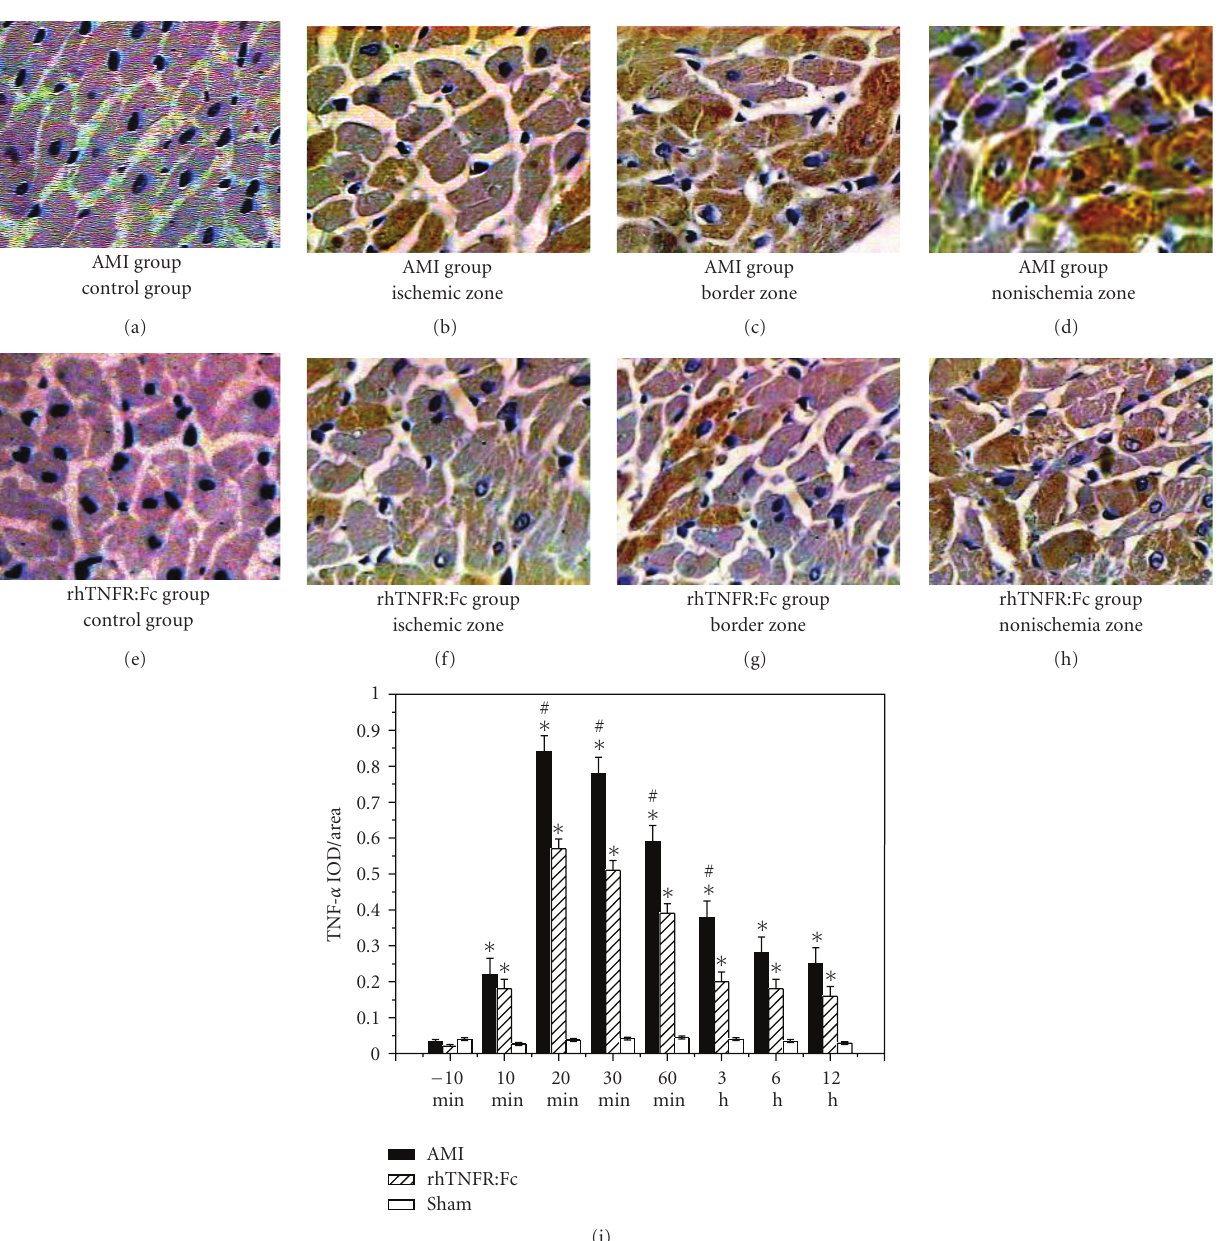
Figure 1: Expression of TNF- α detected by immunohistochemistry. (a)–(d) ( × 400) Expression of TNF- α in the control group, the ischemic zone, the border zone, and the non-ischemia zone of AMI group; (e)–(h) expression of TNF- α in the control group, the ischemic zone, the border zone, and the non-ischemia zone of rhTNFR:Fc group; (i) AMI group or rhTNFR:Fc group versus sham-operation group, ∗ P < . 05. AMI group versus rhTNFR:Fc group, # P < .